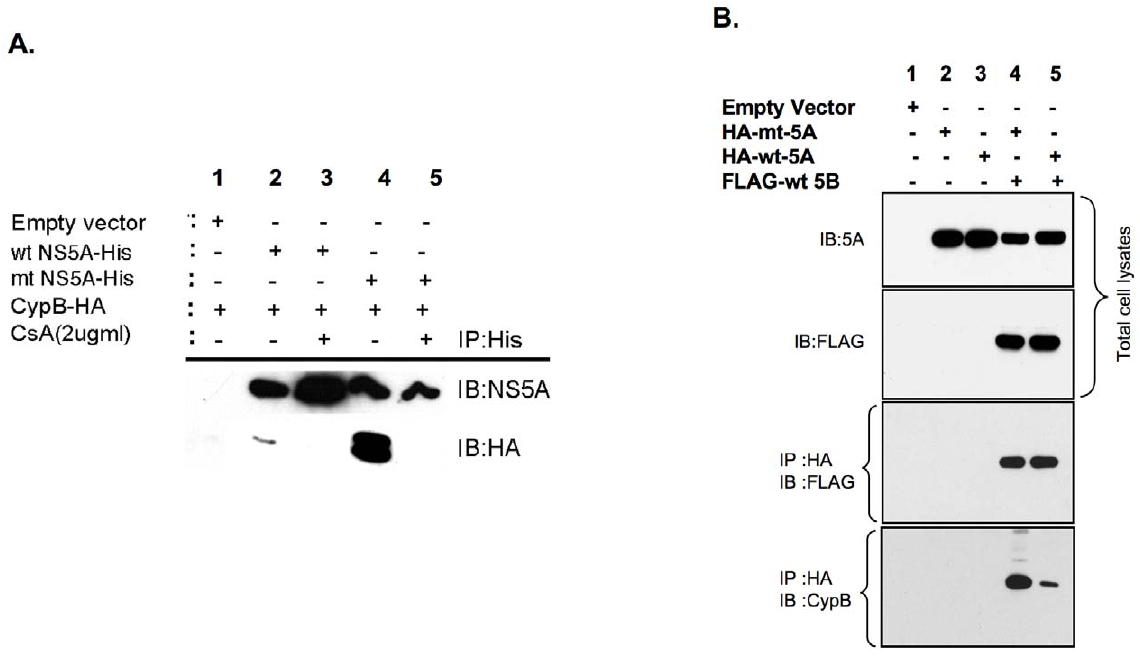
Figure 6. Mutant NS5A binds CypB better than wild-type NS5A in cells. (A) 293T cells were co-transfected with either wt-NS5A-His (lanes 2 and 3) or mt- NS5A-His (lanes 4 and 5) together with HA-tagged CypB in the presence and absence of 2.0 m g/ml CsA. Forty eight hours after transfections, cell lysates were immunoprecipitated with anti-His antibody. The immunoprecipitates (IP) were Western blotted and probed with NS5A-specific and HA-specific antibodies to detect NS5A and CypB respectively. Lane 1 represents transfections with an empty vector control. (B) 293T cells were co-transfected with either HA-wt NS5A (lanes 3 and 5) or HA-mt NS5A (lanes 2 and 4) in the presence (lanes 4 and 5) or absence (lanes 1–3) of FLAG-wt NS5B (Con 1b). Lane 1 represents transfections with an empty vector control. Forty eight hours after transfections, cell lysates were immunoprecipitated with anti-HA antibody and Western blotted. The blots were probed with antibodies specific for NS5A (top blot), FLAG (to detect NS5B (middle blot), and CypB (lower blot) respectively. Upper two blots show total cell lysate without HA-specific immunoprecipitation.